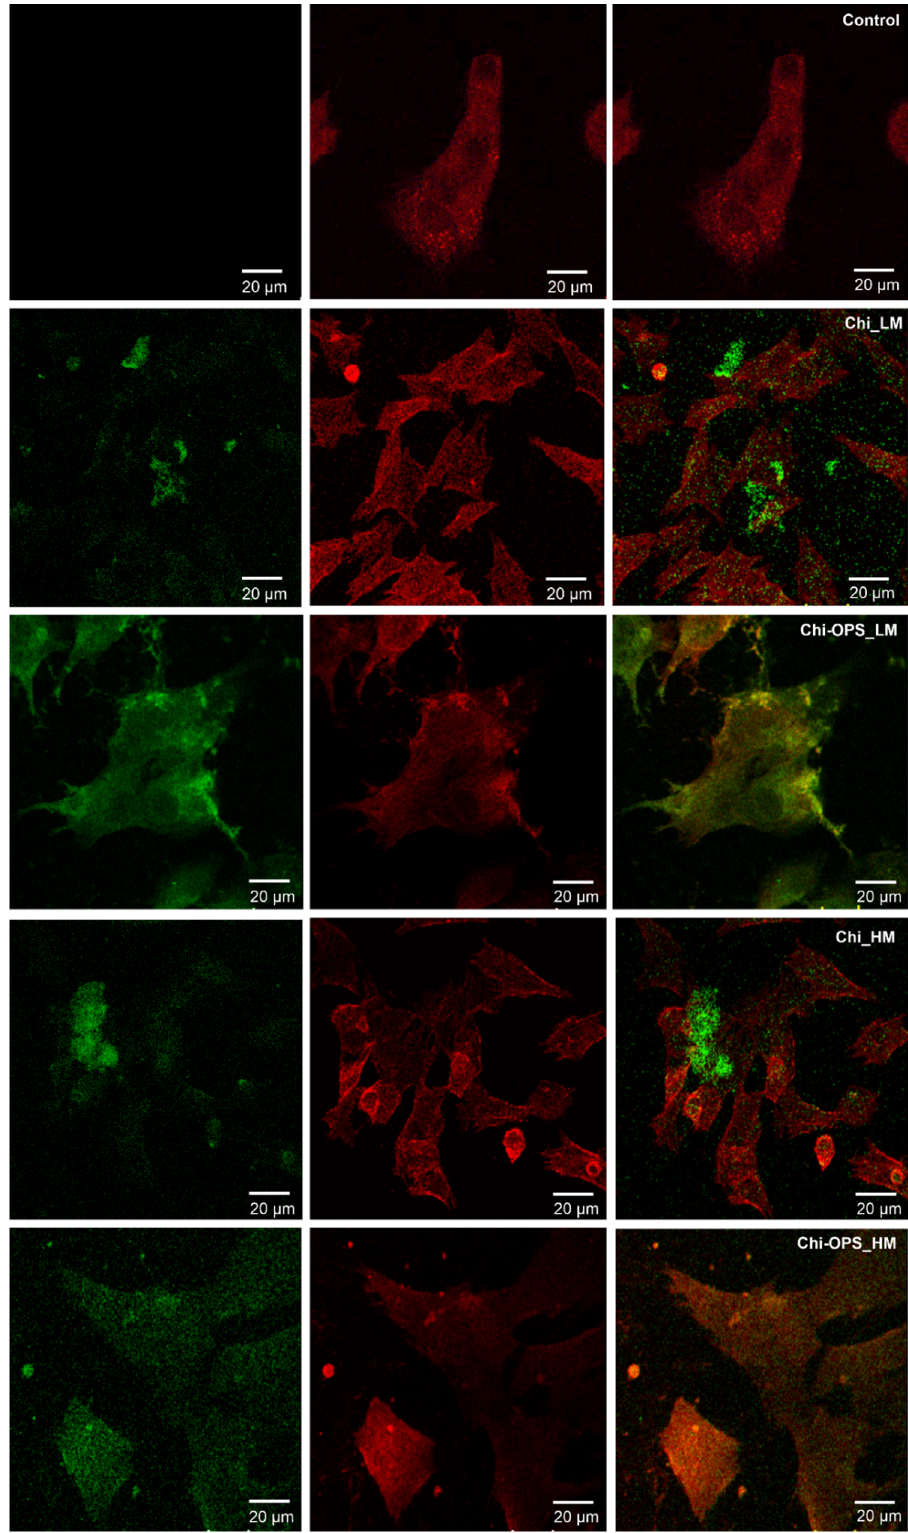
Figure 8. Fluorescence Microscope images of the HBMSC cells nanoparticles uptake. CdSQD particles (green) and early endosome (red) were stained. Scale bar: 20 µm. In the Caveolin 1 expression RT-PCR results with HBMSC, MG63, and HDFn, the difference between the different cell lines cultured with the Quantum dots is not